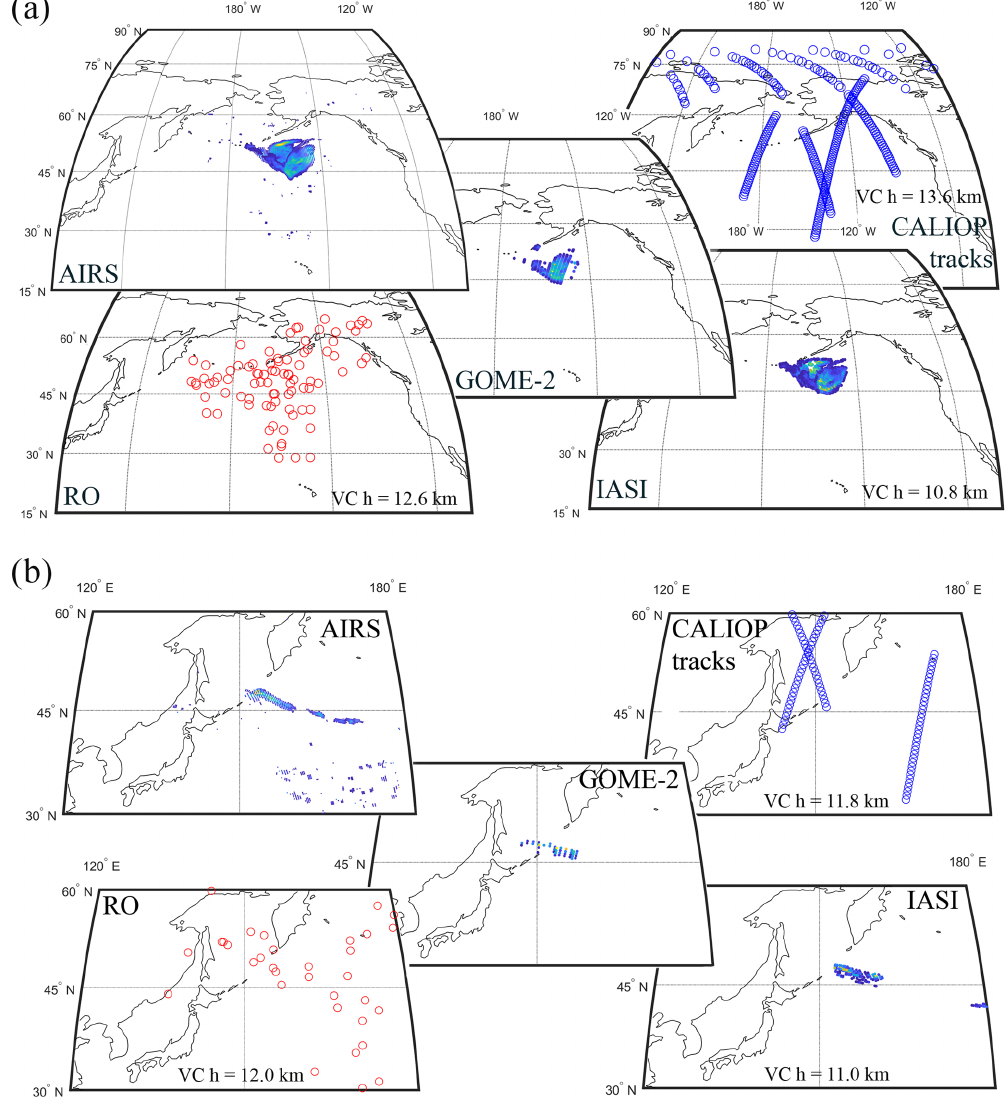
Figure 2. Example of data use and data collocation. (a) Kasatochi cloud on 9 August 2008; (b) Sarychev Peak cloud on 12 June 2009. The central panels show the SO 2 VCD two-dimensional spreading estimated by AIRS, GOME-2 and IASI; the top right panel shows the CALIOP tracks for which the total attenuated backscatter profile is available; and the bottom left panel shows the RO profiles collocated with the SO 2 . For IASI, CALIOP and RO the average volcanic cloud-top altitude for the considered day is indicated (VC